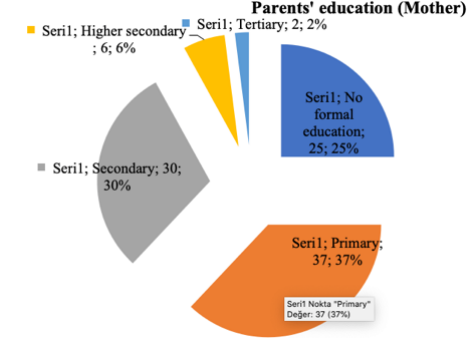
Figure 4: Parent’s Education